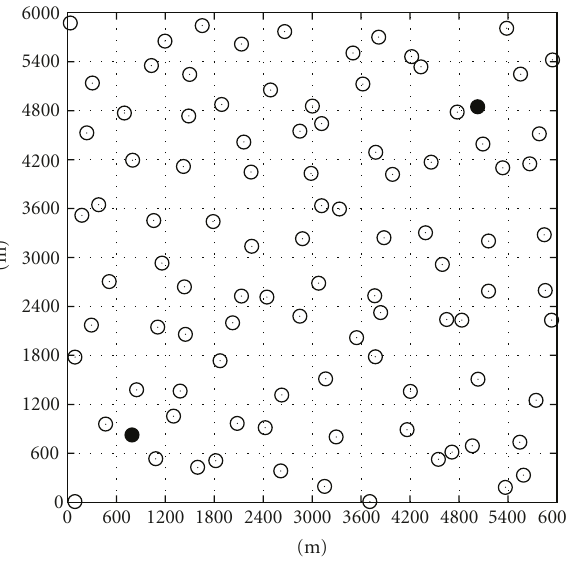
Figure 8: Node placement of one case of the simulation